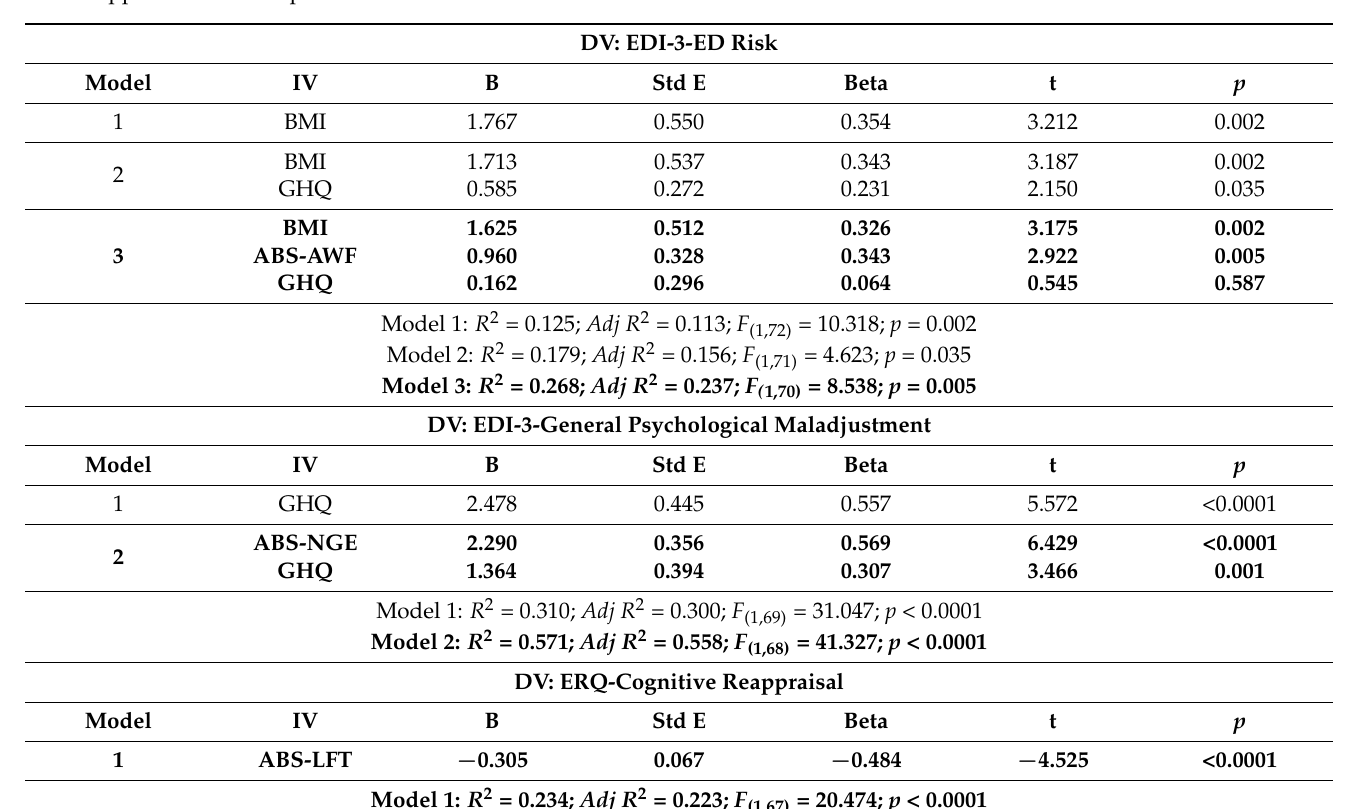
Table 2. Stepwise regression analysis to predict ED-specific symptomatology, ED-related psychopathology, and cognitive reappraisal in ED